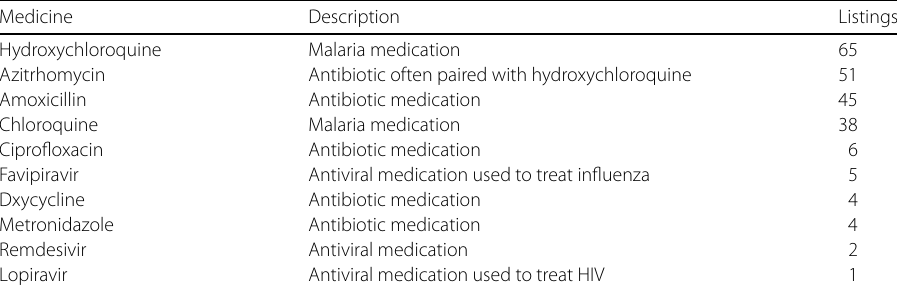
Table 8 COVID-19 related medicines appearing in the listings, together with a brief description and the number of listings related to that drug